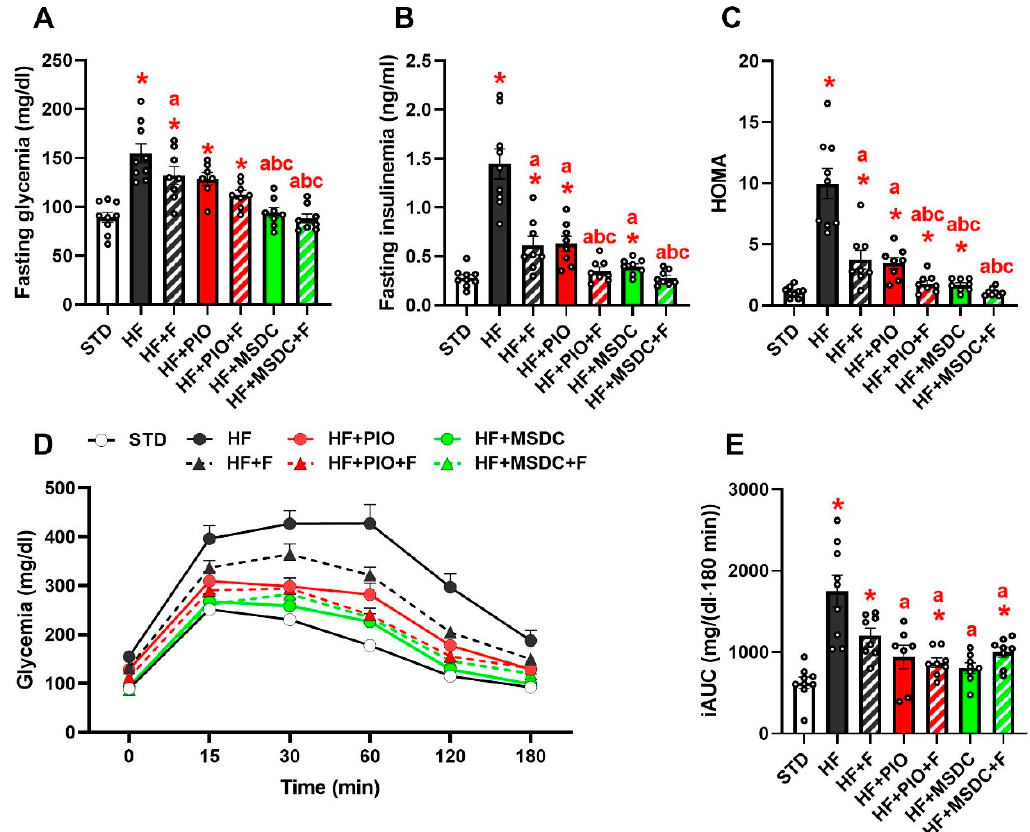
Figure 3. Glucose homeostasis. Mice were fed STD or various HF diets for 8 weeks. Glycemia ( A ) and insulinemia ( B ) after overnight fasting; HOMA index ( C ); intraperitoneal GTT: time course of glycemia during the test ( D ) and the corresponding incremental area under the curve (iAUC; ( E )). Data are means ± SEMs ( n = 8). * Significantly di ff erent from STD ( p ≤ 0.05, t -test). a—significantly di ff erent vs. HF; b—significantly di ff erent vs. HF + F; c—significantly di ff erent vs. HF + PIO ( p ≤ 0.05, one-way ANOVA). HOMA: homeostatic model assessment; GTT: glucose tolerance test. For designation of dietary groups, see Section 2.1.